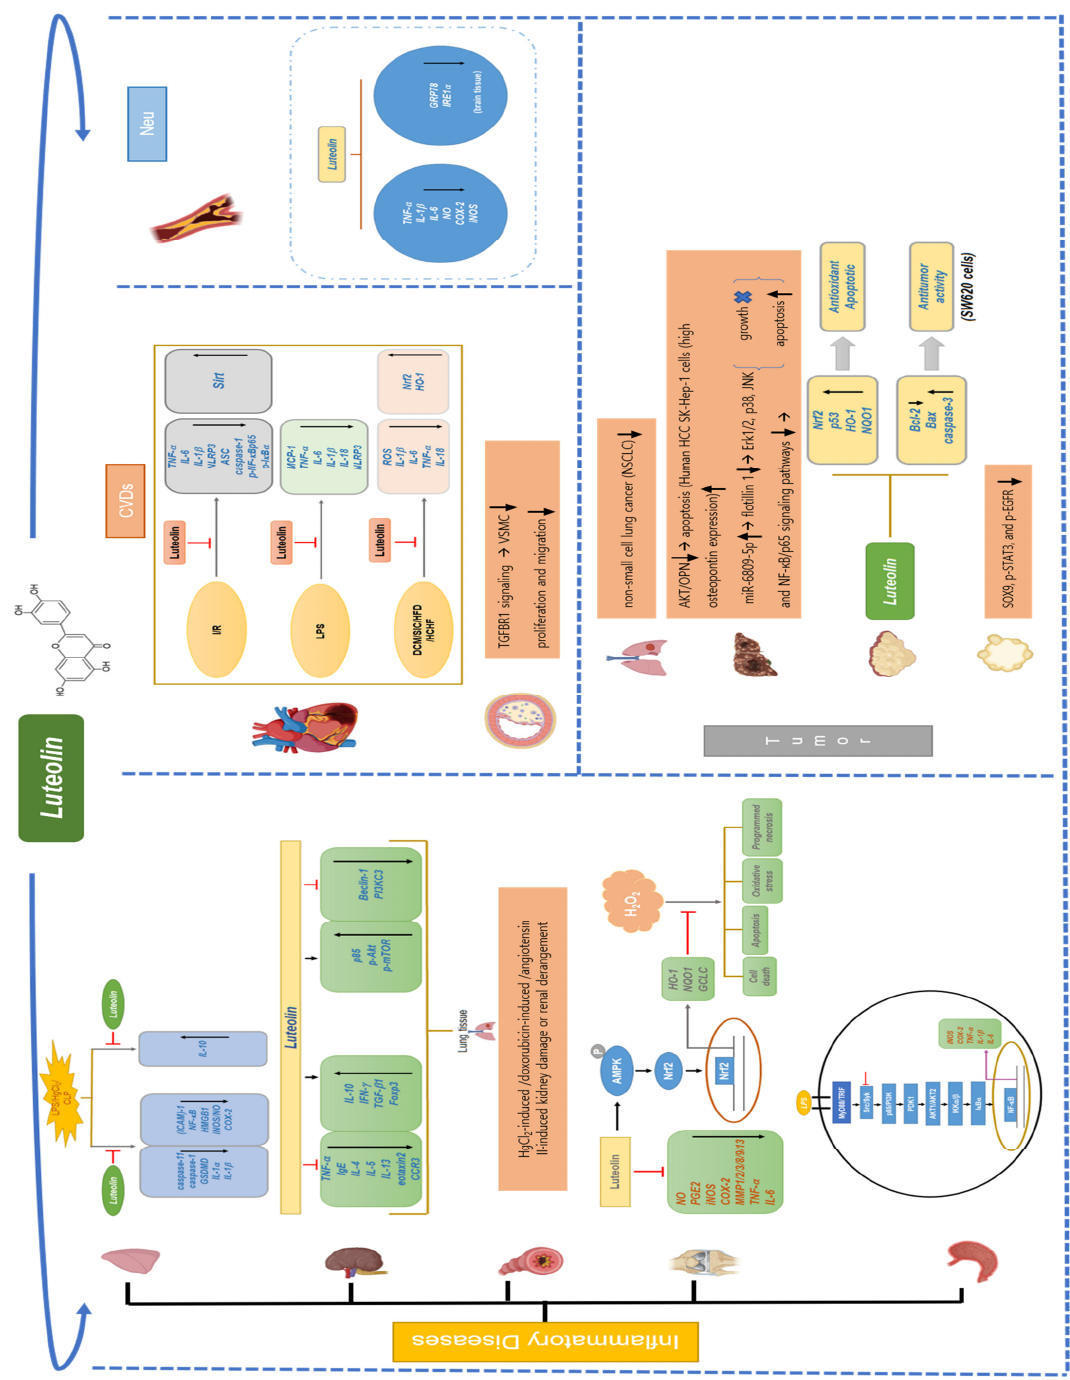
Figure 7. Molecular mechanism of the anti-inflammatory effects of luteolin in different diseases. The immunopharmacological effect of luteolin is summarized in terms of different tissues or organs, target molecules, stimulation conditions, and target cytokines/chemokines. Arrows in up: increase, Arrows in down: decrease, ⊥ :